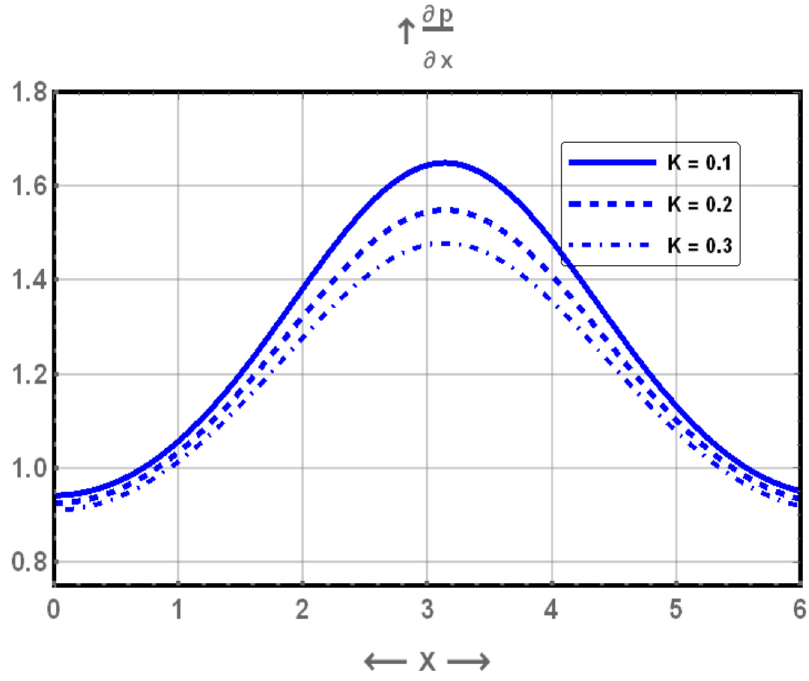
Figure 17. Display of pressure gradient for different values of K .